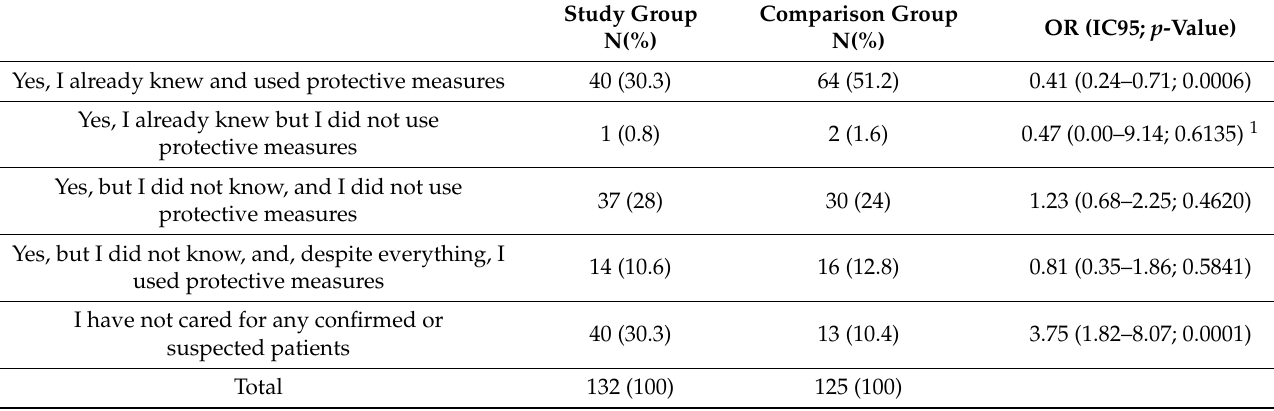
Table 2. Care of suspected/confirmed COVID-19 patients and the use of protective measures (%). Study